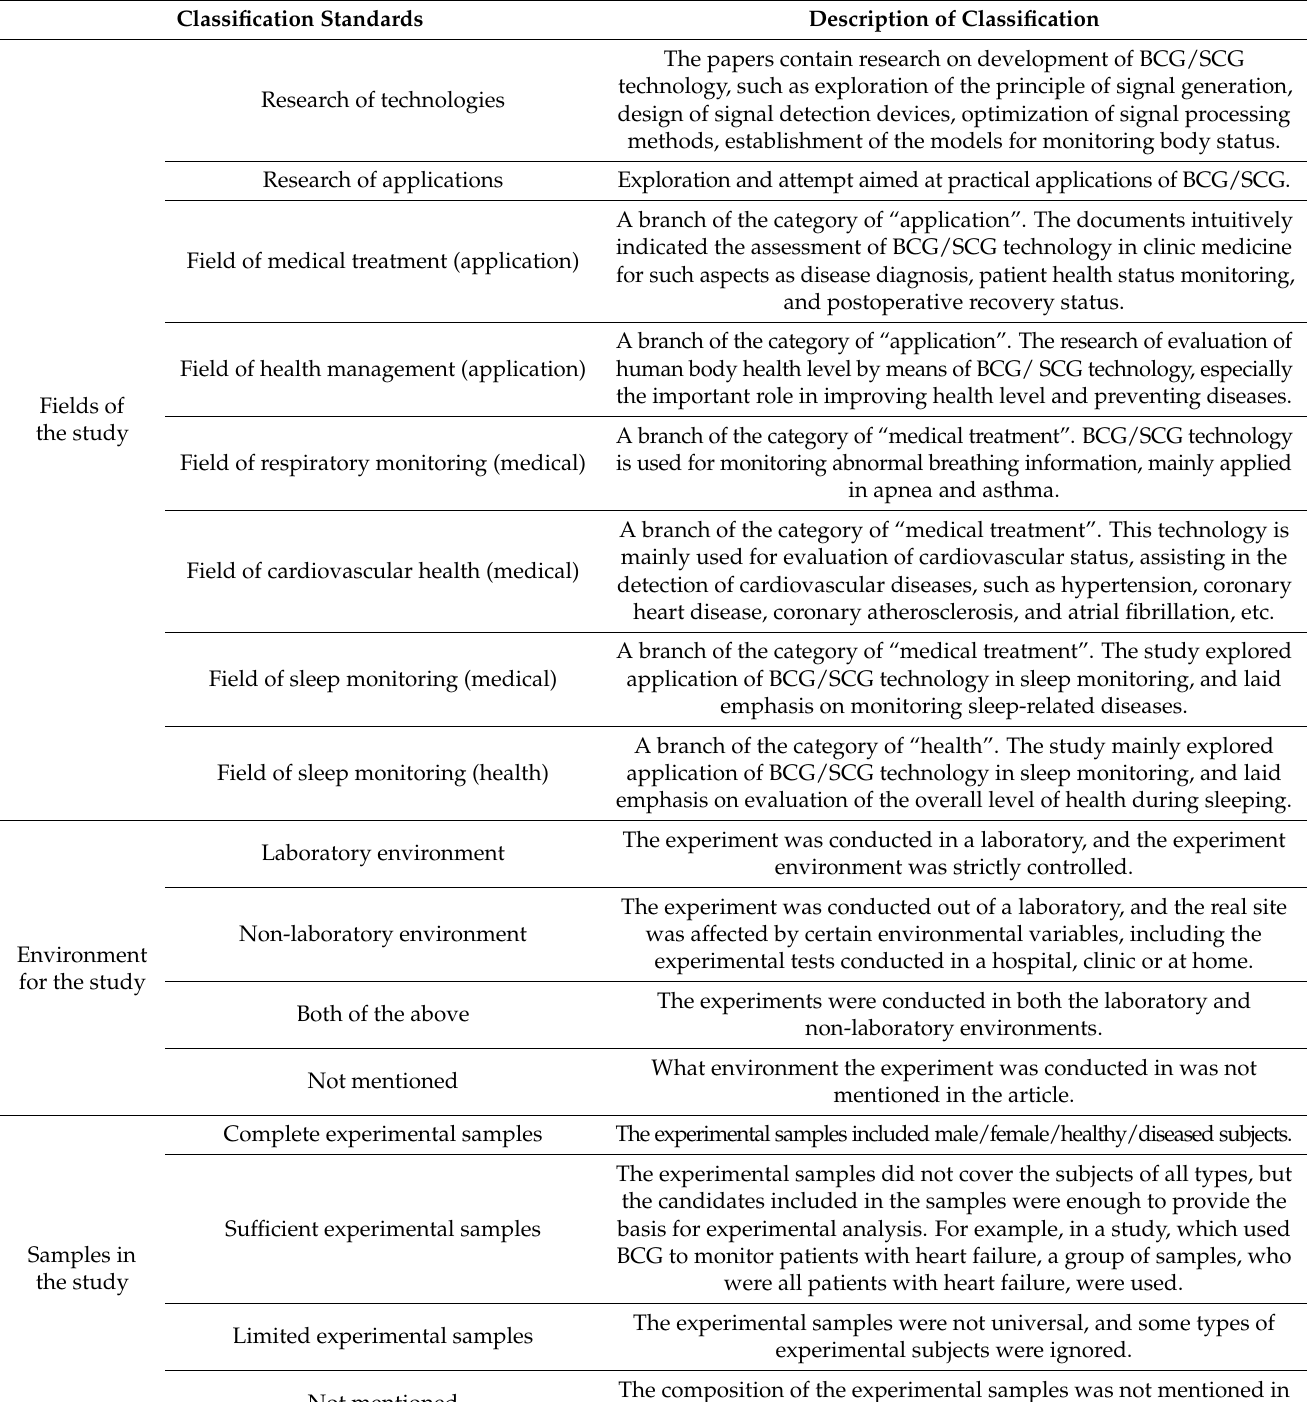
Table 1. Standards for Classification of